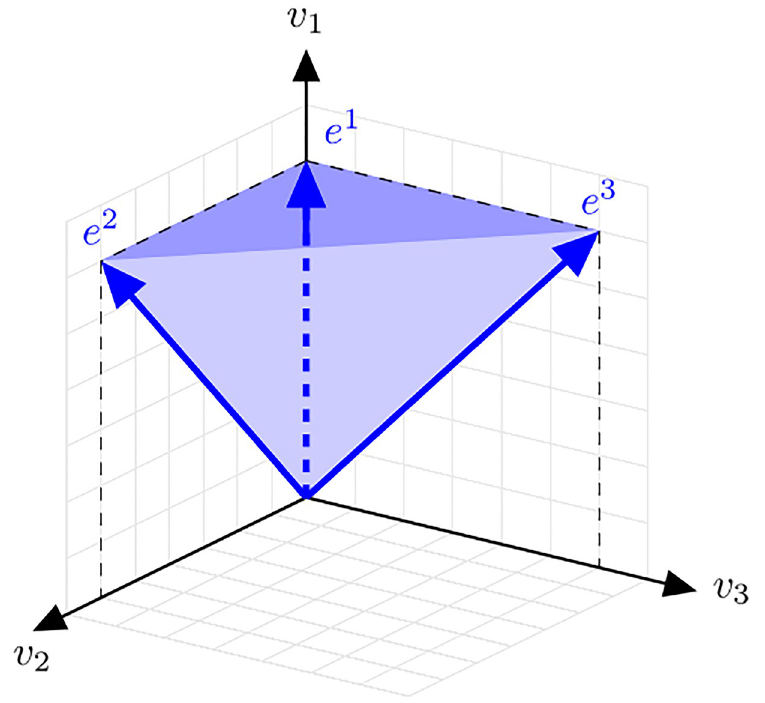
Fig 7. A polyhedral cone (that is not an